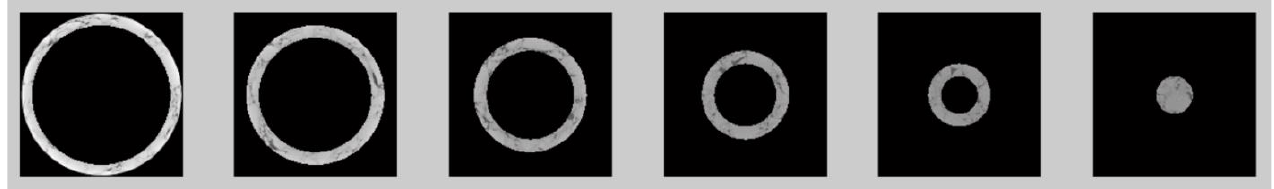
Figure 5. Six sub-images of CT image after annular partition.